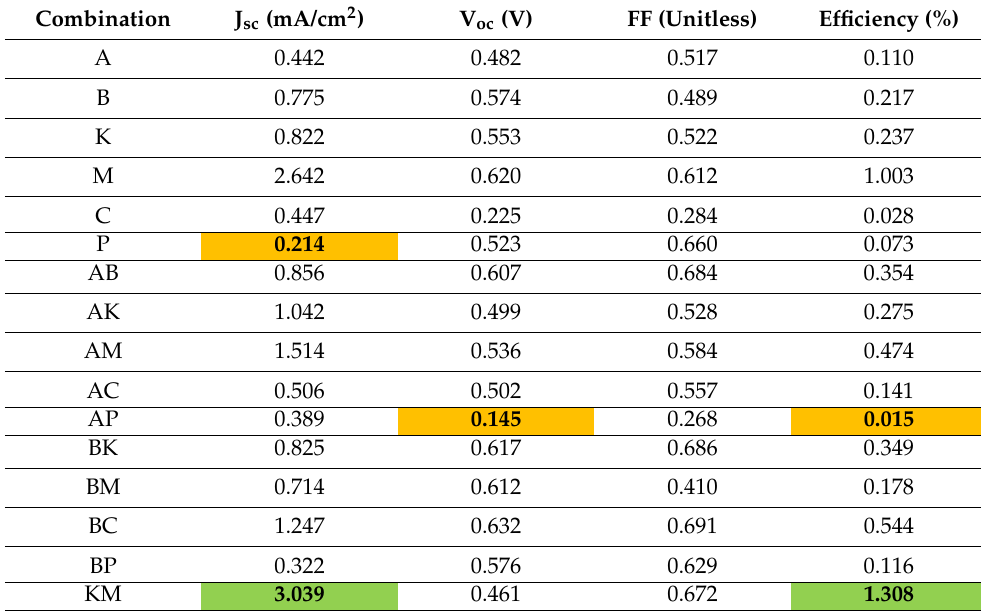
Figure 7. LHE of the six optimized combinations referenced against the AM1.5G solar irradiance spectrum. Note the parity of combinations 1 and 3 as well as combinations 4 and 6 as indicated in Tables 3 and 4. Table 5. IV data of all DSSCs produced in this Table 4. Optimized dye solutions from anode-adsorbed UV-Vis data (reference Figure 7, quadrants III and IV).